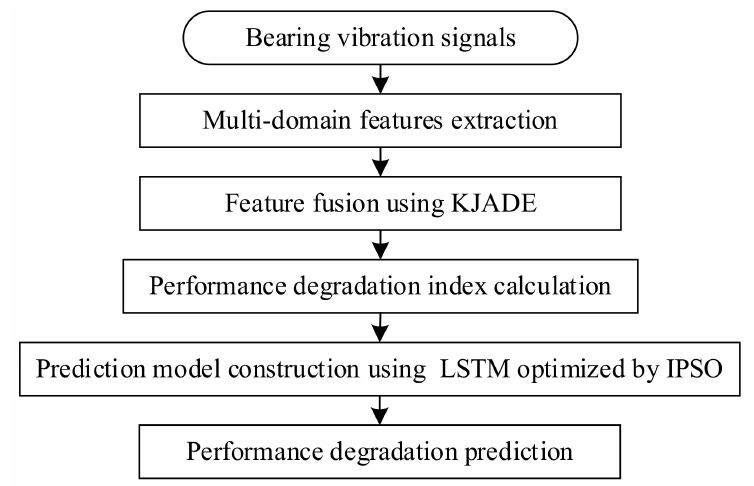
Figure 3. Performance degradation prediction by